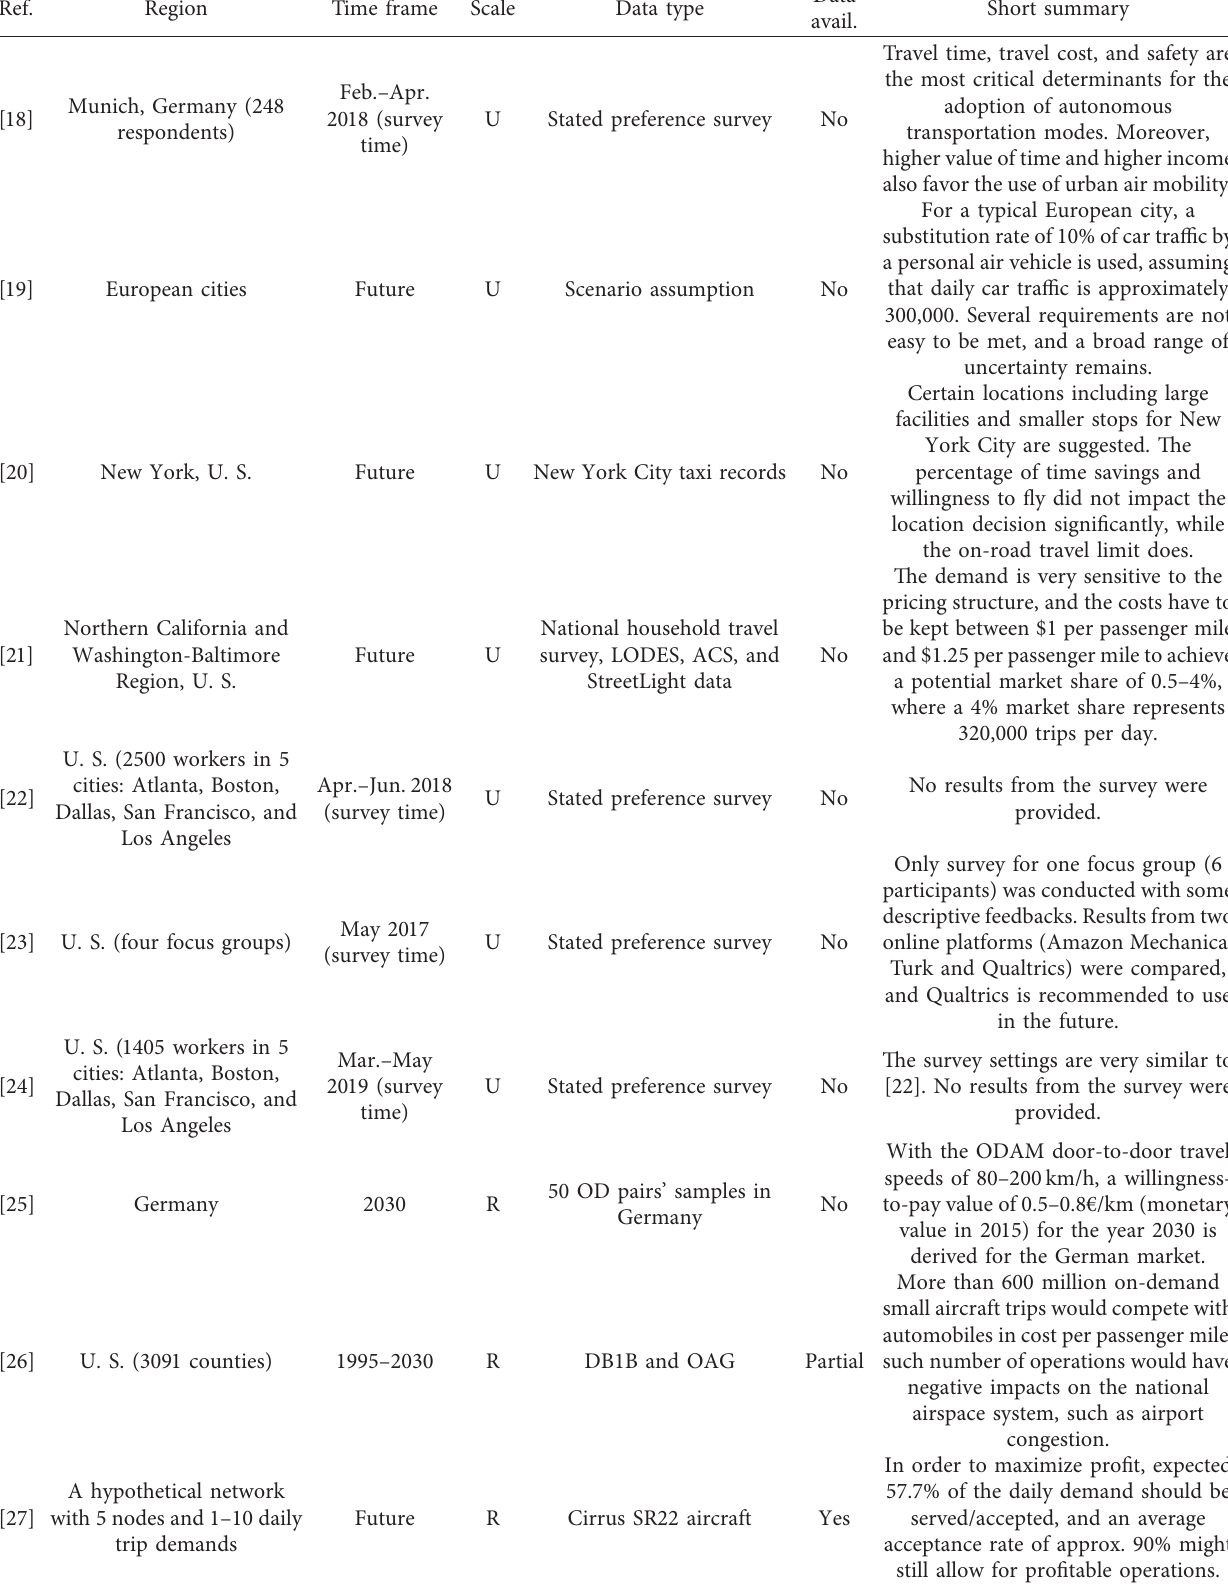
Table 1: An overview of the ODAM demand